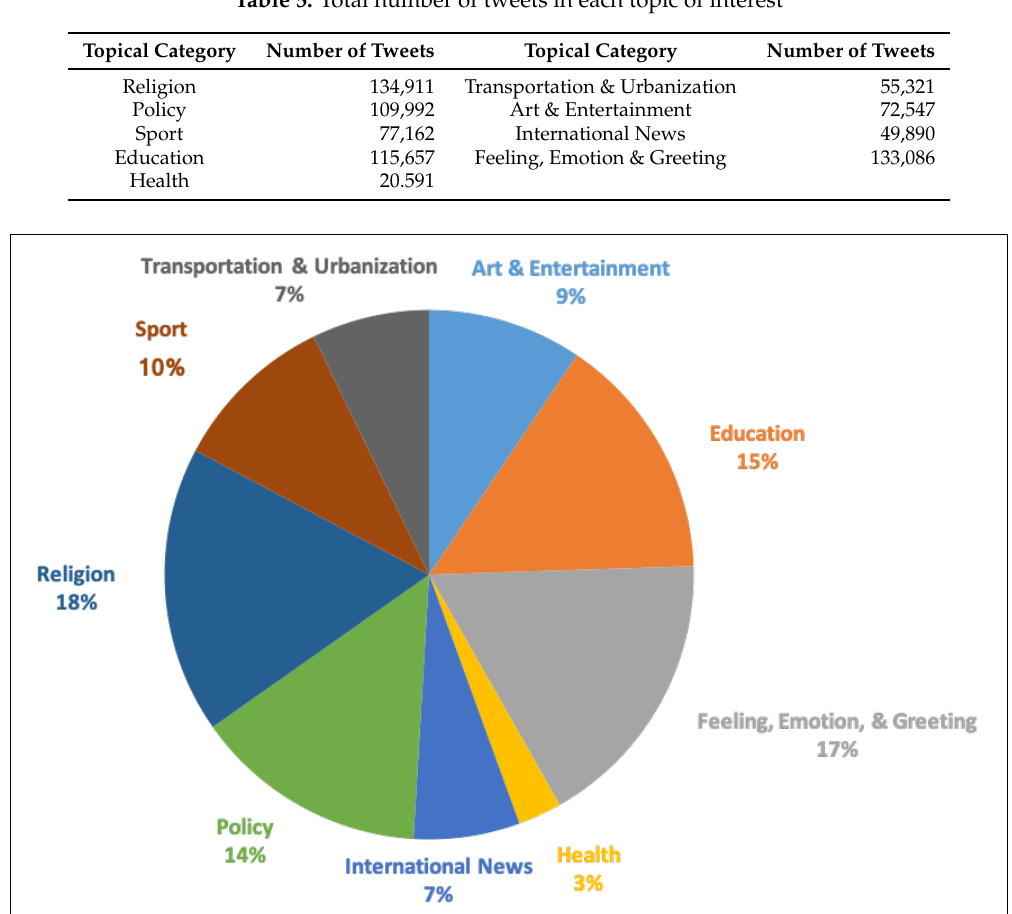
Table 5. Total number of tweets in each topic of interest